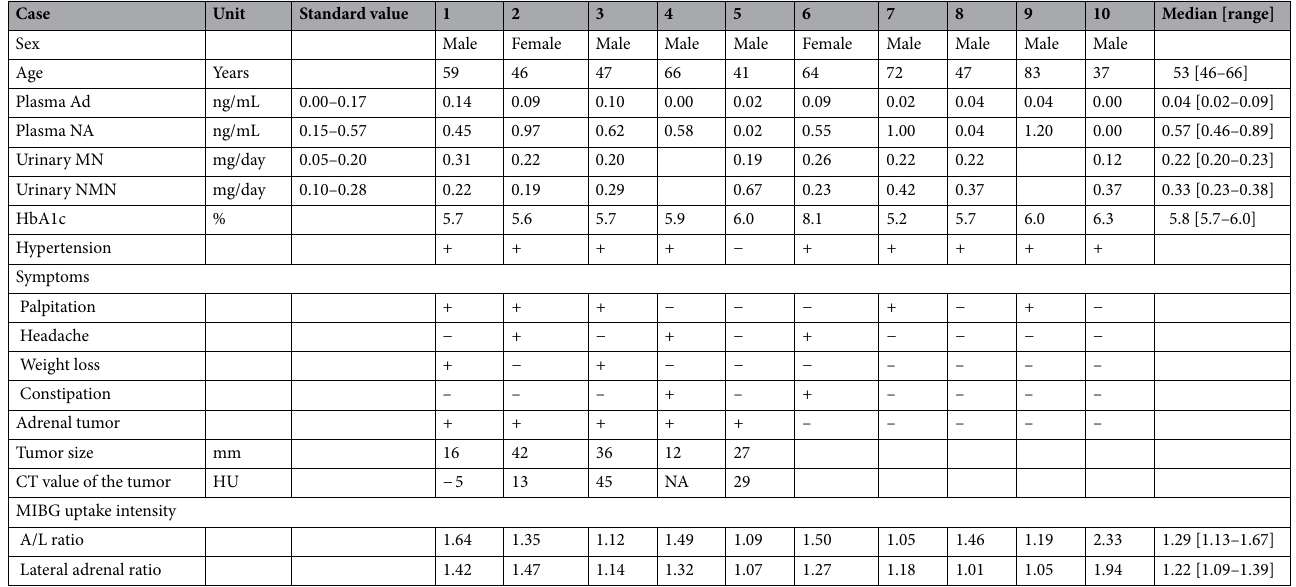
Table 1. Clinical characteristics of 10 cases with bilateral adrenal accumulation with MIBG and a mild increase in CA or